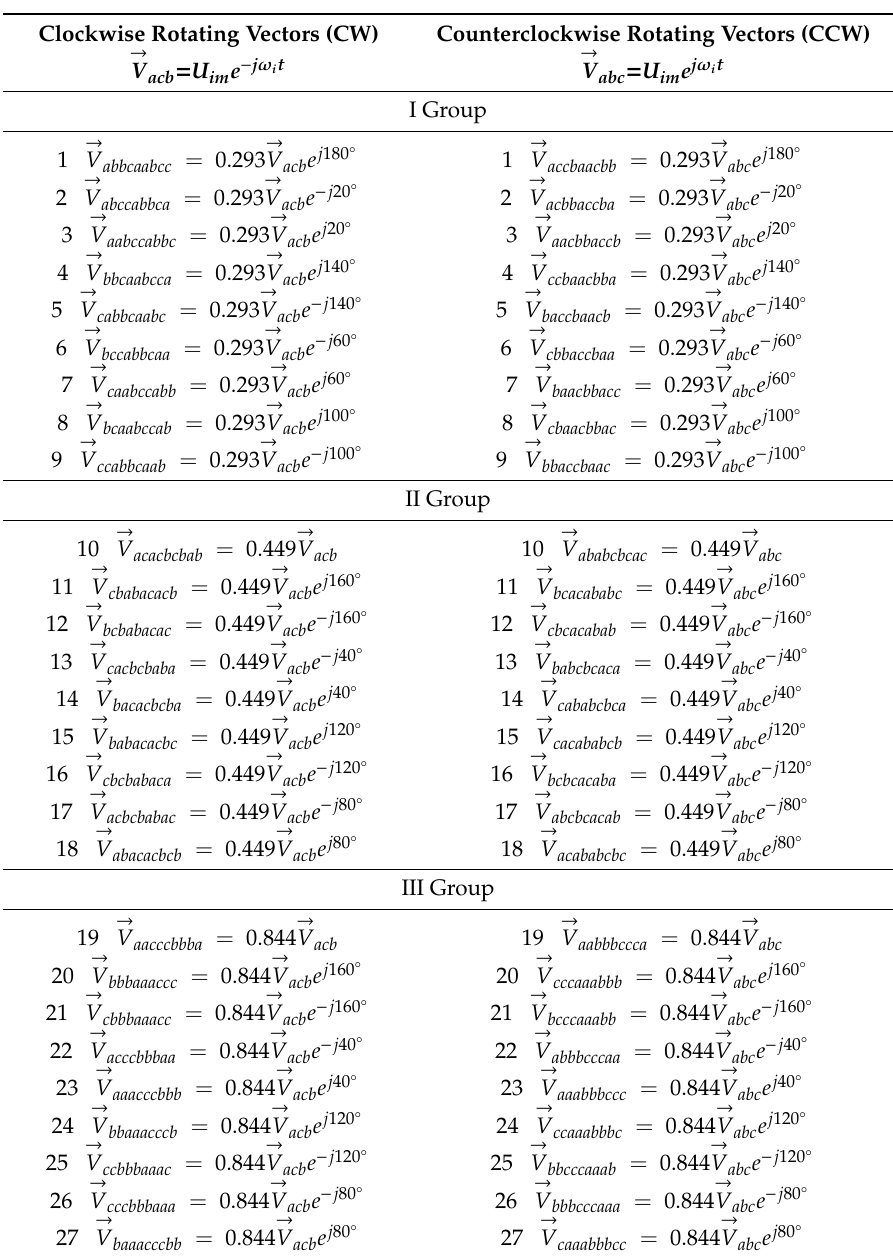
Table 2. Rotating space vectors of group 12 resulting in elimination of the common mode voltage